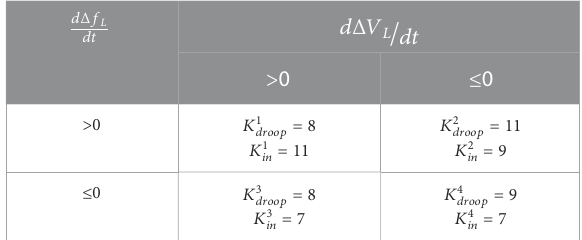
TABLE 4 K droop and K in weights under different working